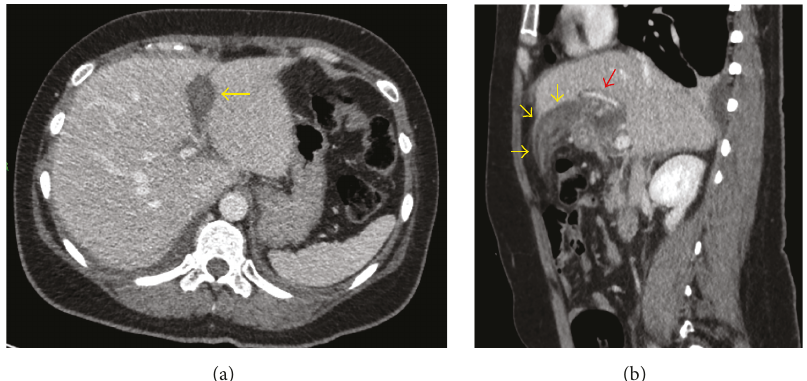
Figure 1: Abdominal axial (a) and sagittal (b) CT scan showing thrombosed falciform ligament (yellow arrows) with patent left portal vein (red arrow).